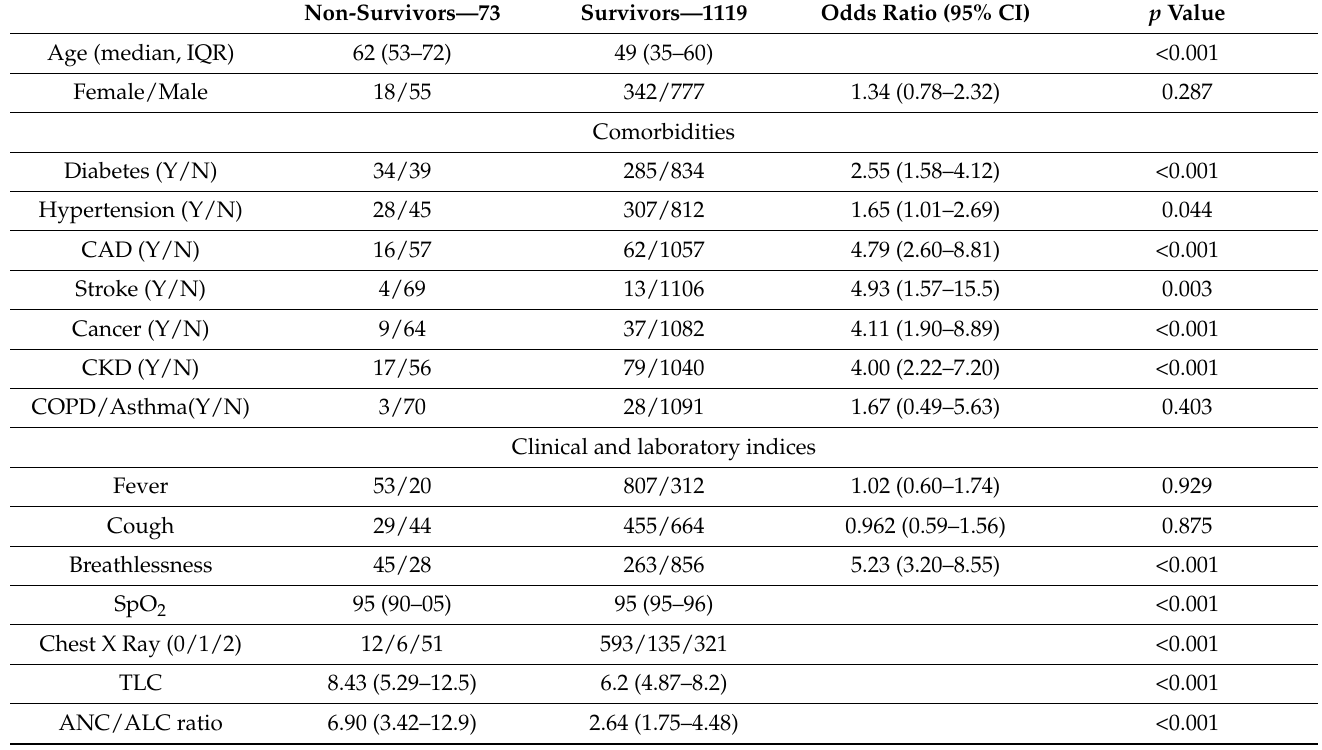
Table 4. Predictors of mortality in COVID-19